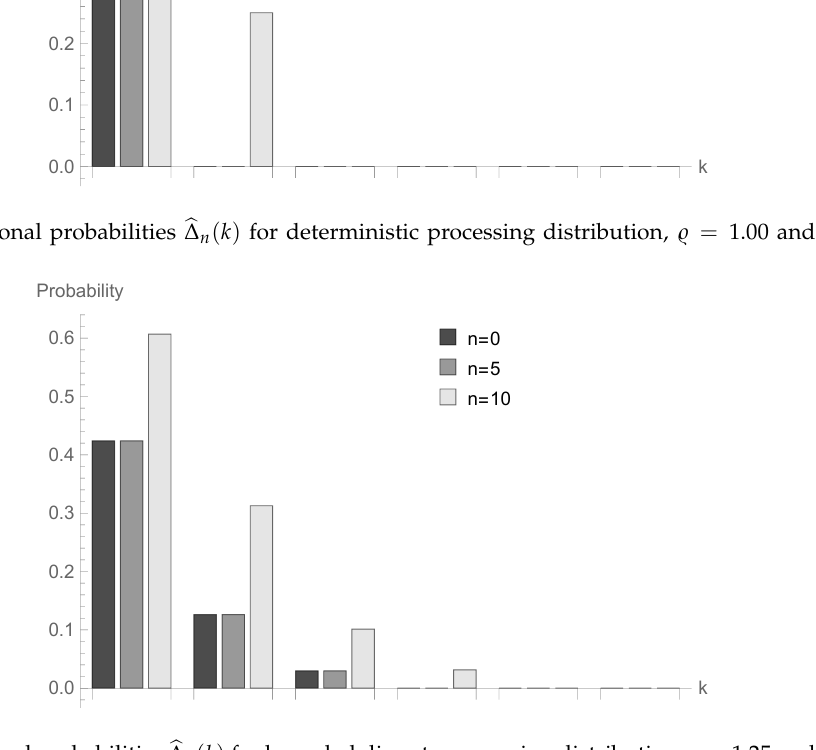
Figure 3. Conditional probabilities (cid:98) ∆ n ( k ) for bounded discrete processing distribution, (cid:36) = 1.25 and n = 0,5 and